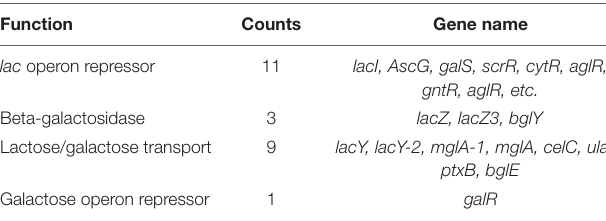
TABLE 2 | Lactose/galactose related functional genes annotated in Erwinia sp. E602